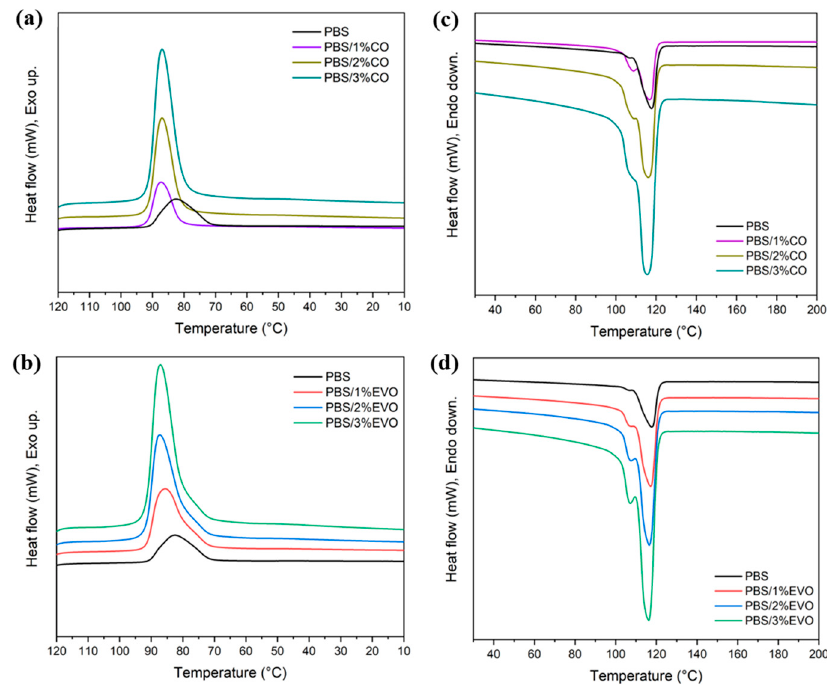
Figure 2. The DSC curves of enthalpy of crystallization: ( a ) PBS and PBS/CO and ( b ) PBS and PBS/EVO. The DSC curves of enthalpy of melting: ( c ) PBS and PBS/CO and ( d ) PBS and PBS/EVO.